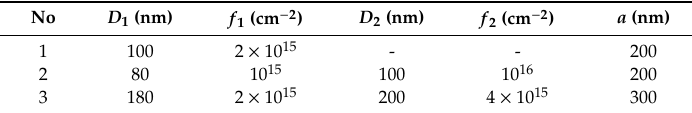
irradiated with the uniform He + ion fluence (2.5 × 10 15 ions/cm 2 ) within a spot. ( b ) Magnetization hysteresis loop of the same structure. Crosses are the experimental data. The orange solid line is the loop obtained using numerical simulations.